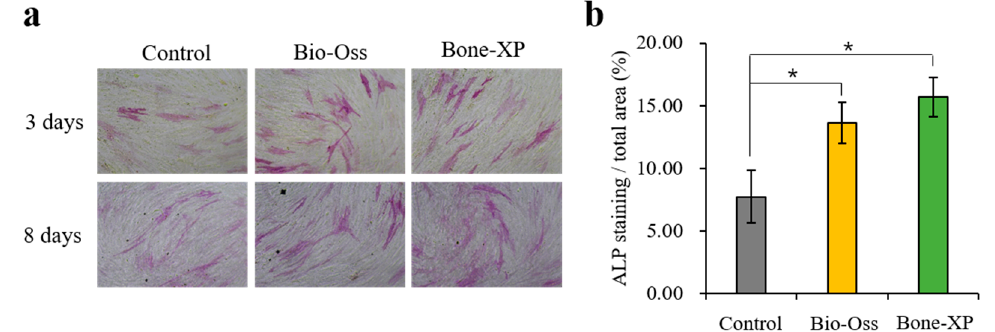
Figure 6. Cell osteogenic differentiation assay. ( a ) Alkaline phosphatase (ALP) staining and ( b ) the quantitative analysis. The symbol * indicates statistical significance compare to control (* p < 0.05).